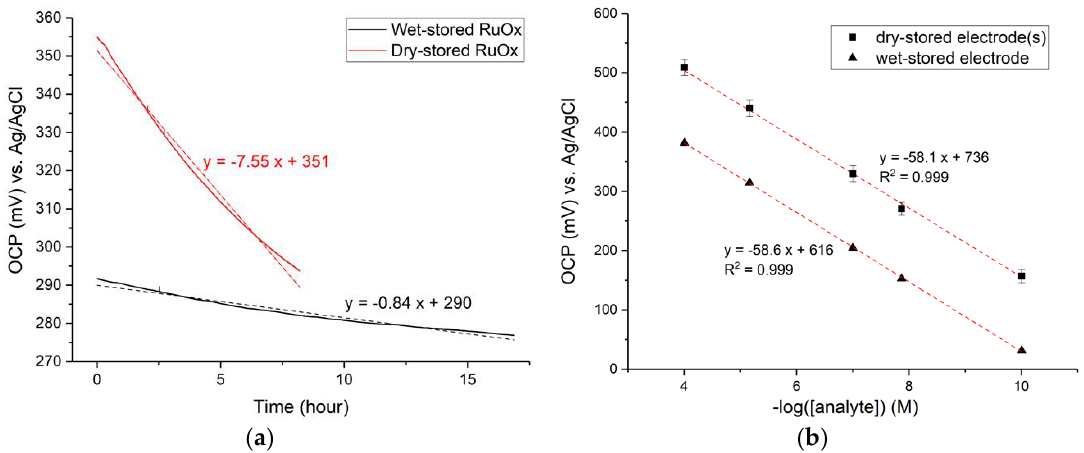
Figure 4. ( a ) Open-circuit potential of RuOx recorded over time in pH 7 buffer, fitted linearly (dotted lines). RuOx electrode showed high drift when stored in air (dry-stored) and significantly lower drift when stored in liquid (wet-stored); ( b ) comparison of open-circuit potential of wet-stored vs. dry-stored RuOx in different pH buffers, fitted linearly.